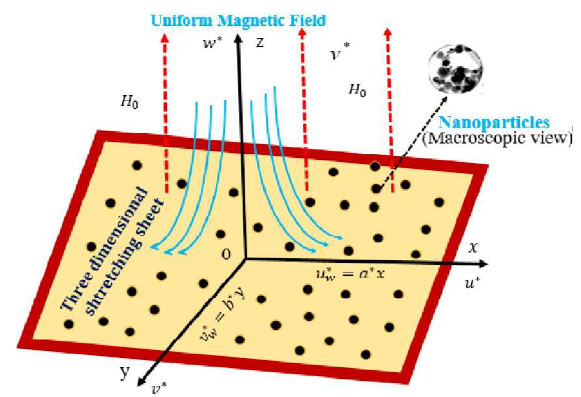
Figure 1: Physical model of the